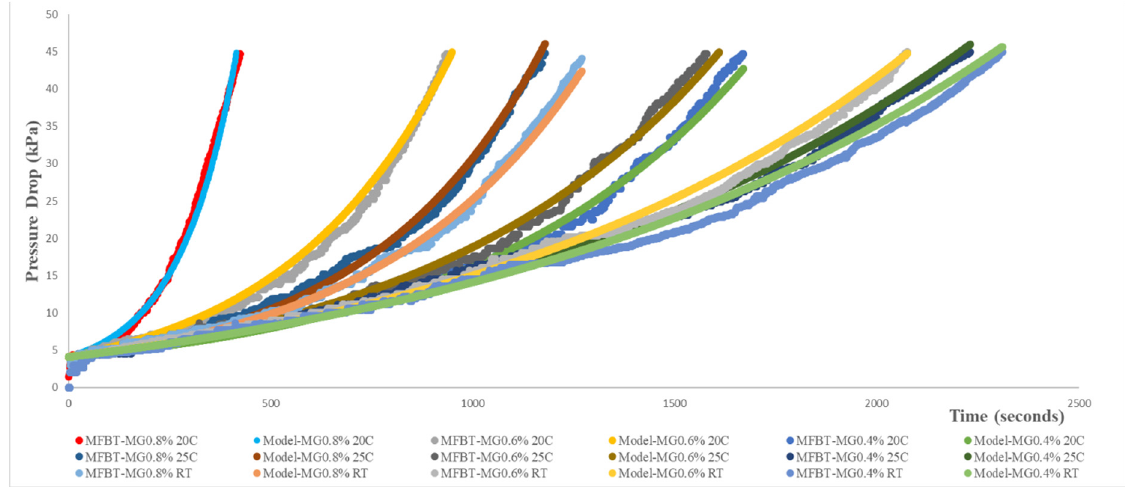
Figure 5. Pressure drop trend resulting from modified FBT test and modelling.